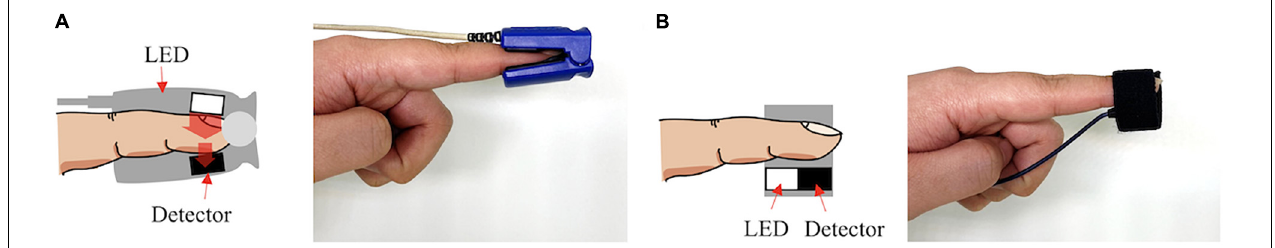
FIGURE 2 | Configuration for photoplethysmography measurement: (A) transmissive type and (B) reflective type.